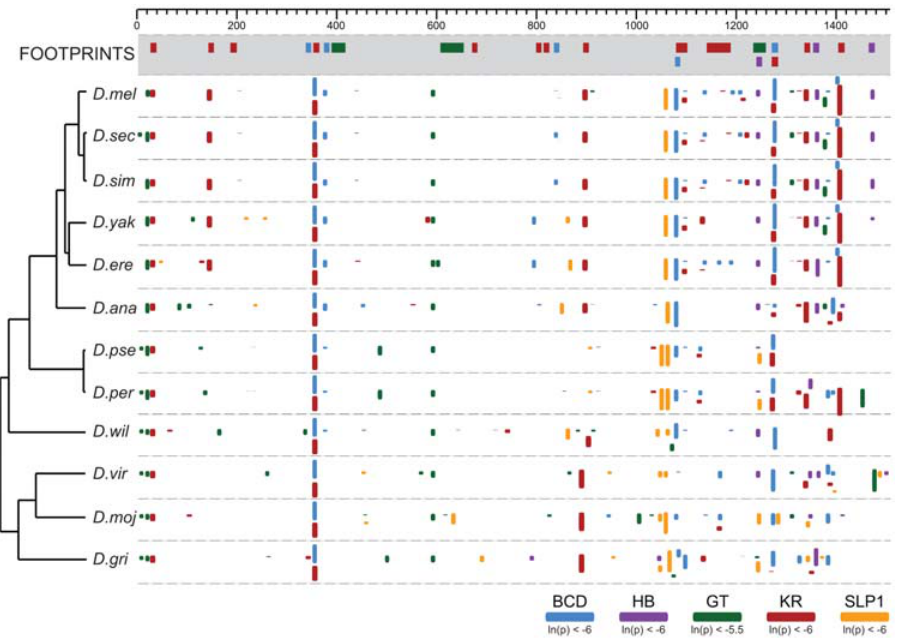
Figure 1. Binding site conservation and turnover in Drosophilaeven-skipped stripe 2 enhancer. Predicted binding sites for the five factors known to regulate expression from the eve stripe 2 enhancer in the twelve sequenced Drosophila species [56]. Sites were predicted independently in each species using PATSER [61] and mapped onto an MLAGAN [65] multiple alignment of the eve stripe 2 enhancer sequences. The height of the box representing each binding site is scaled by its PATSER p-value (taller boxes represent sites with higher predicted affinities). The top panel (grey shading) shows the positions of biochemically-verified (in vitro footprinting) binding sites [27]. The indicated coordinates are for the multiple- alignment, which is longer than individual enhancers due to the high frequency of alignment